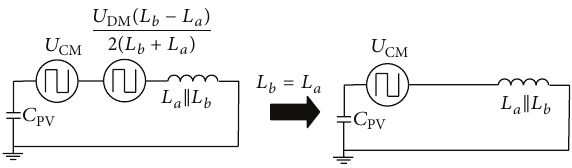
Figure 2: System common mode model.